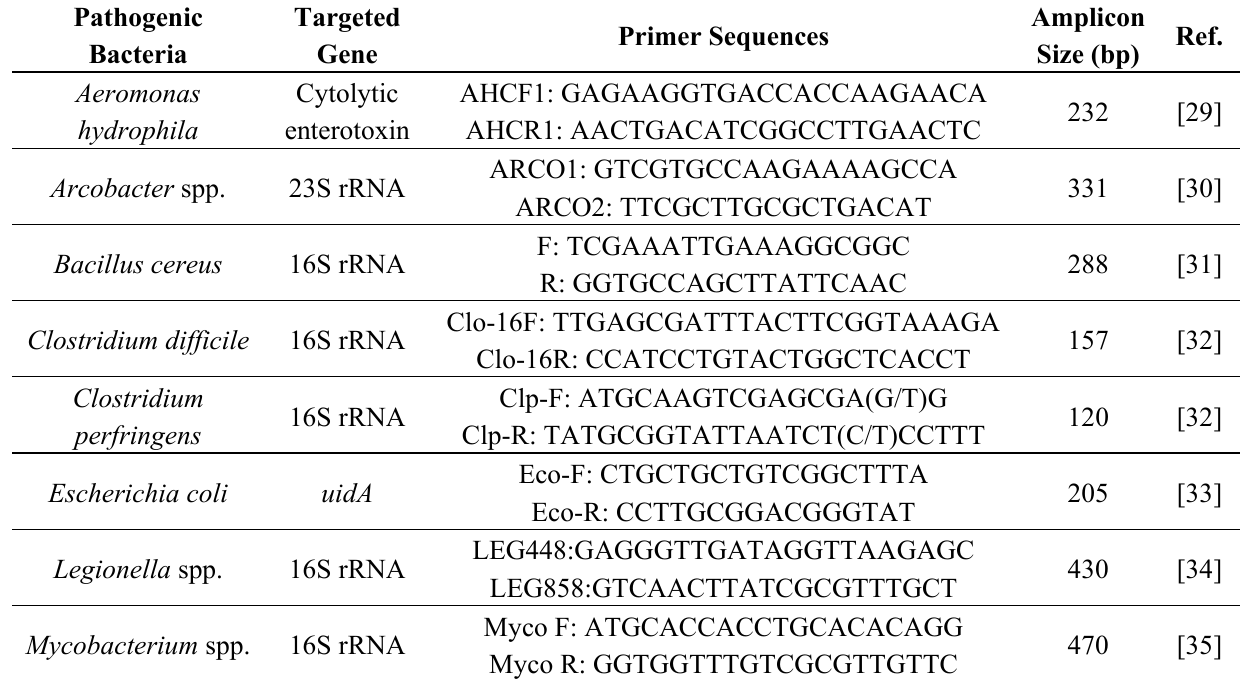
Table 3. Primers of pathogenic bacteria for real-time PCR